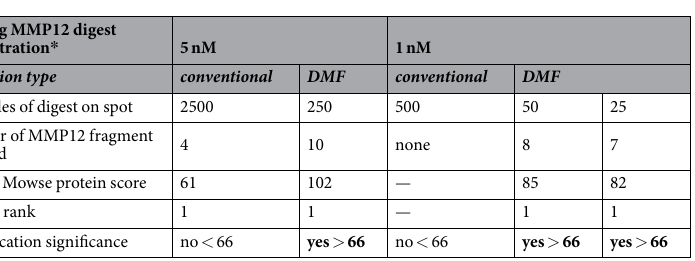
Figure 5. MALDI-TOF MS spectra of MMP12 digest: ( A ) DMF deposition of 250 attomoles, ( B ) Conventional pipette deposition of 2500 attomoles, ( C ) DMF deposition of 50 attomoles. The ticked masses and star-labeled peaks correspond to tryptic fragments of MMP12.